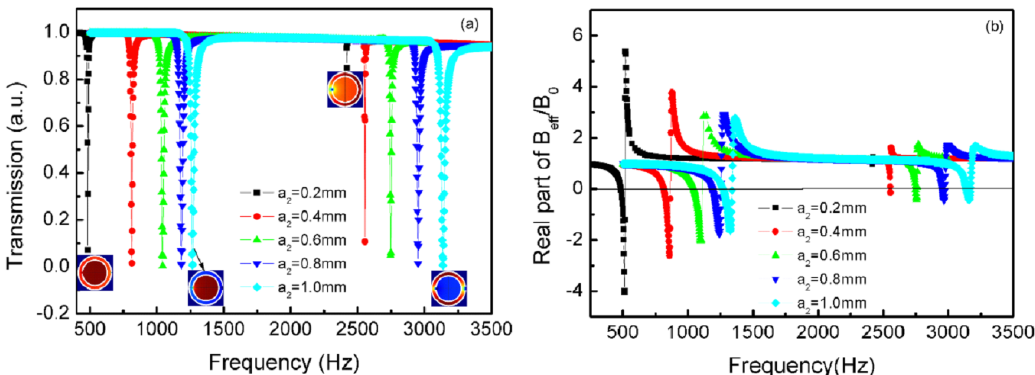
Figure 8. The curves of TLSHSs with various outer hole diameters: ( a ) transmission and ( b ) effective modulus.